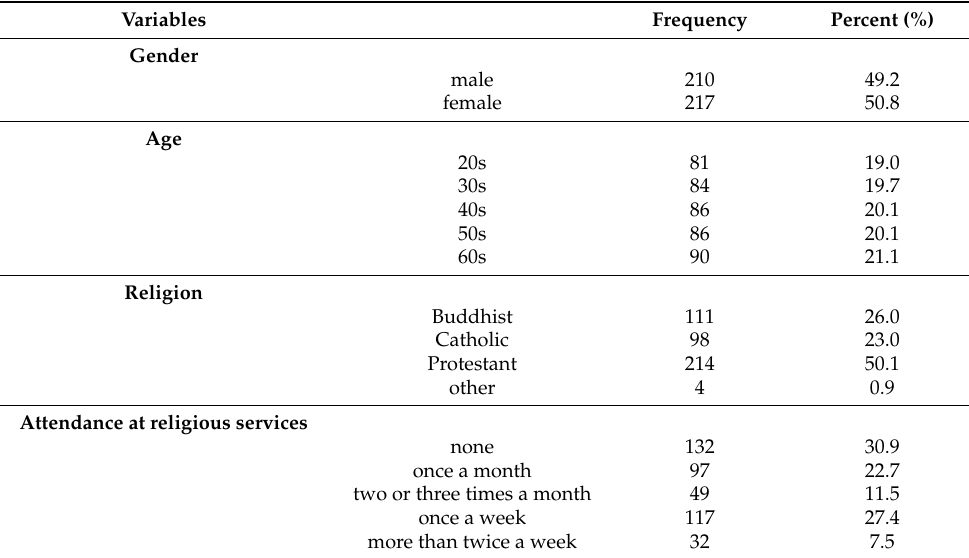
Table 1. Characteristics of participants ( N = 427).